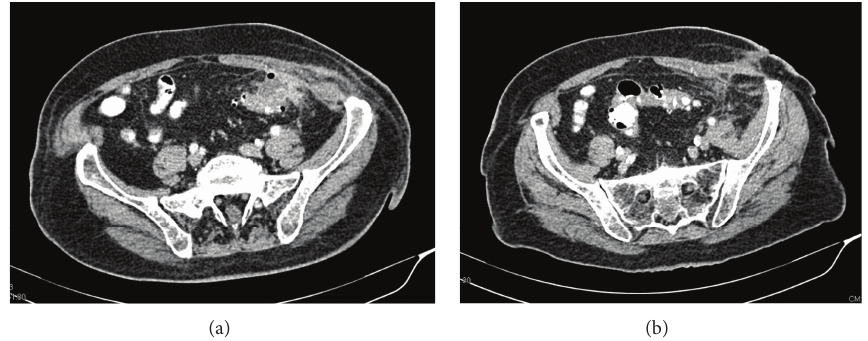
Figure 6: Contrast enhanced abdomen MDCT after surgical drainage of the abscess shows regression of the pericolic inflammation (a), decrease of the quantity of extraluminal air (a), and almost complete regression of the abdominal wall abscess (b). We can also notice the site of drainage in the subcutaneous fat